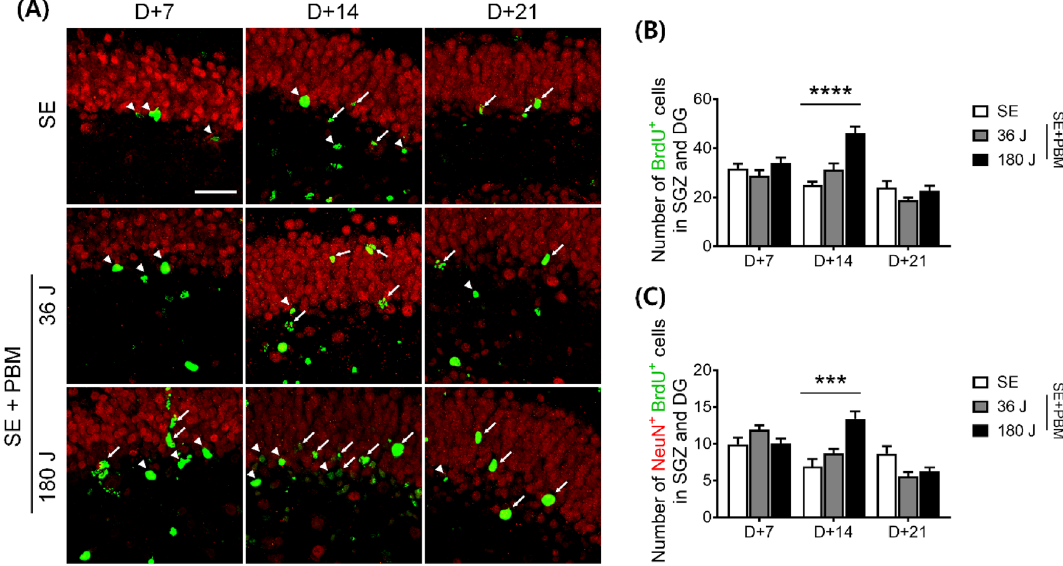
Figure 4. PBM increased newly generated/proliferating neurons in the SGZ and DG of the hippocampus after excitotoxicity by SE. ( A ) Representative coronal section views of Z-stacks obtained by confocal microscopy show the localization of BrdU and NeuN positive cells (white arrow head, BrdU-positive only; white arrow, BrdU and NeuN double-positive cells) in the SGZ and DG of the hippocampus. Scale bar 50 µm. Immunostaining was performed with NeuN (for mature neuron, red) and BrdU (for newly generated cell, green). ( B ) Quantification of the number of newly generated cells in the SGZ and DG is shown. Only BrdU-positive cells increased in the SGZ and DG of the hippocampus in the PBM treated groups compared to the SE group in 180 J PBM at 14 days. The quantitative data are presented as the mean ± SEM. ****P < 0.0001 compared with to SE group. ( C ) Quantification of the number of newly generated/proliferating neurons in the SGZ and DG is shown. NeuN and BrdU double positive cells increased of the hippocampal DG in the PBM treated groups compared to the SE group in 180 J PBM at 14 days. The quantitative data are presented as the mean ± SEM. ***P < 0.001 compared with to SE group. This figure was generated with Microsoft Visio version 2016 (Microsoft, Redmond, WA,